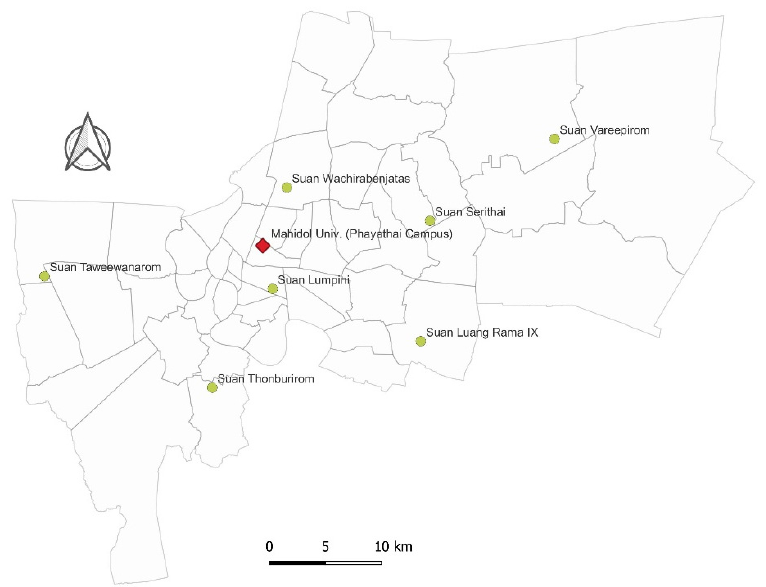
Figure 1. The distribution of public parks and build up areas within the Bangkok metropolitan area. The green color indicates the public parks used for animal sampling. The red color indicates the urban area trapping site located at Mahidol University (Phayathai Campus).